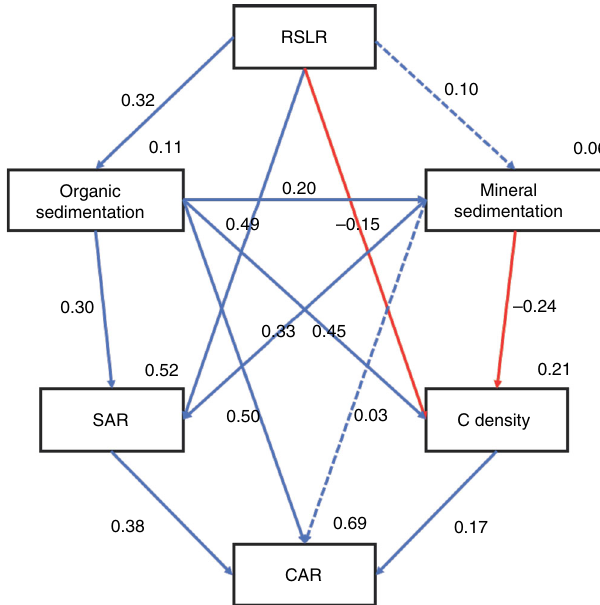
Fig. 6 Pathway analysis is showing the direct and indirect effect of RSLR on CAR. RMSEA = 0.046, GFI = 0.996, χ 2 = 3.12, Probability = 20.5%. Solid (Blue: Positive; Red: Negative) arrows indicate signi fi cant ( p < 0.05) effects. Values associated with solid arrows represent standardized path coef fi cients. R 2 values associated with response variables indicate the proportion of variation explained by relationships with other variables. The high probability associated with the χ 2 tests indicate good model fi t to data, i.e., no signi fi cant